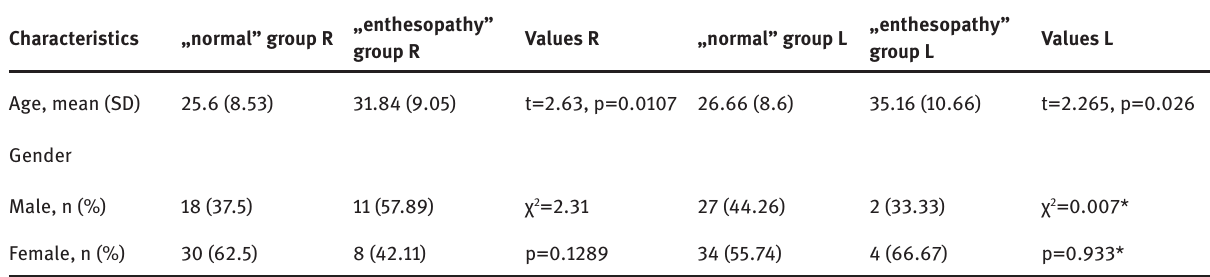
Table 1: Demographic characteristics (USG R and L)